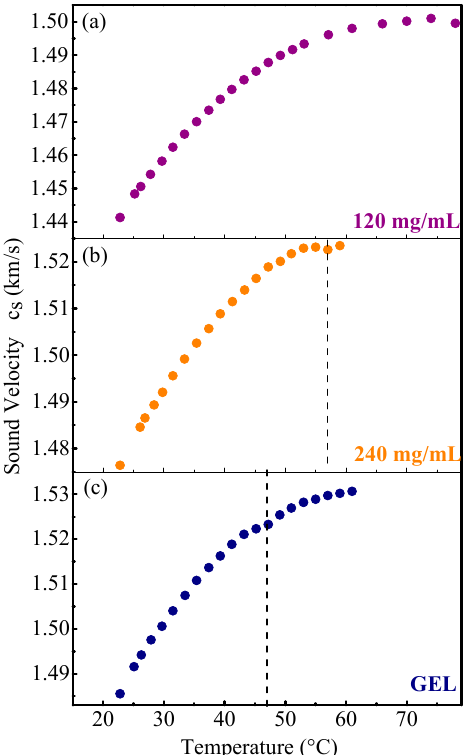
Figure 3. Temperature dependence of the sound velocity on: ( a ) The diluted (120 mg/mL) lysozyme solution, ( b ) the concentrated (240 mg/mL) lysozyme solution and ( c ) the gel system. The vertical lines point out the temperatures where the speed sound variations take place.